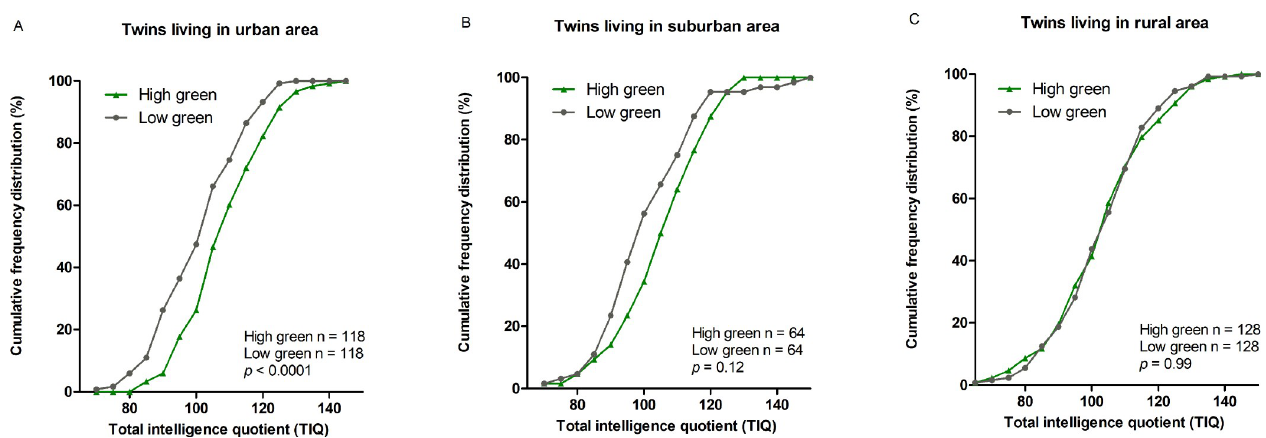
Fig 3. This graph displays the cumulative frequency distribution of total IQ scores in children residing in high and low green space (based on the median) in twins living in (A) an urban, (B) a suburban, and (C) a rural area. IQ, intelligence quotient; TIQ, total intelligence quotient.